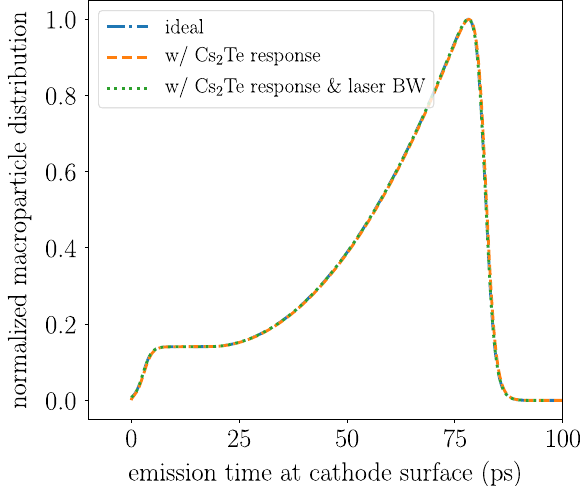
FIG. 5. Programmed macroparticle distributions at the photo- cathode surface: for an optimized laser pulse (blue trace), taking into account the photocathode response (orange trace), and both the cathode response and finite bandwidth (BW) of the laser pulse (green trace). The laser bandwidth is taken to be δ f ¼ 2